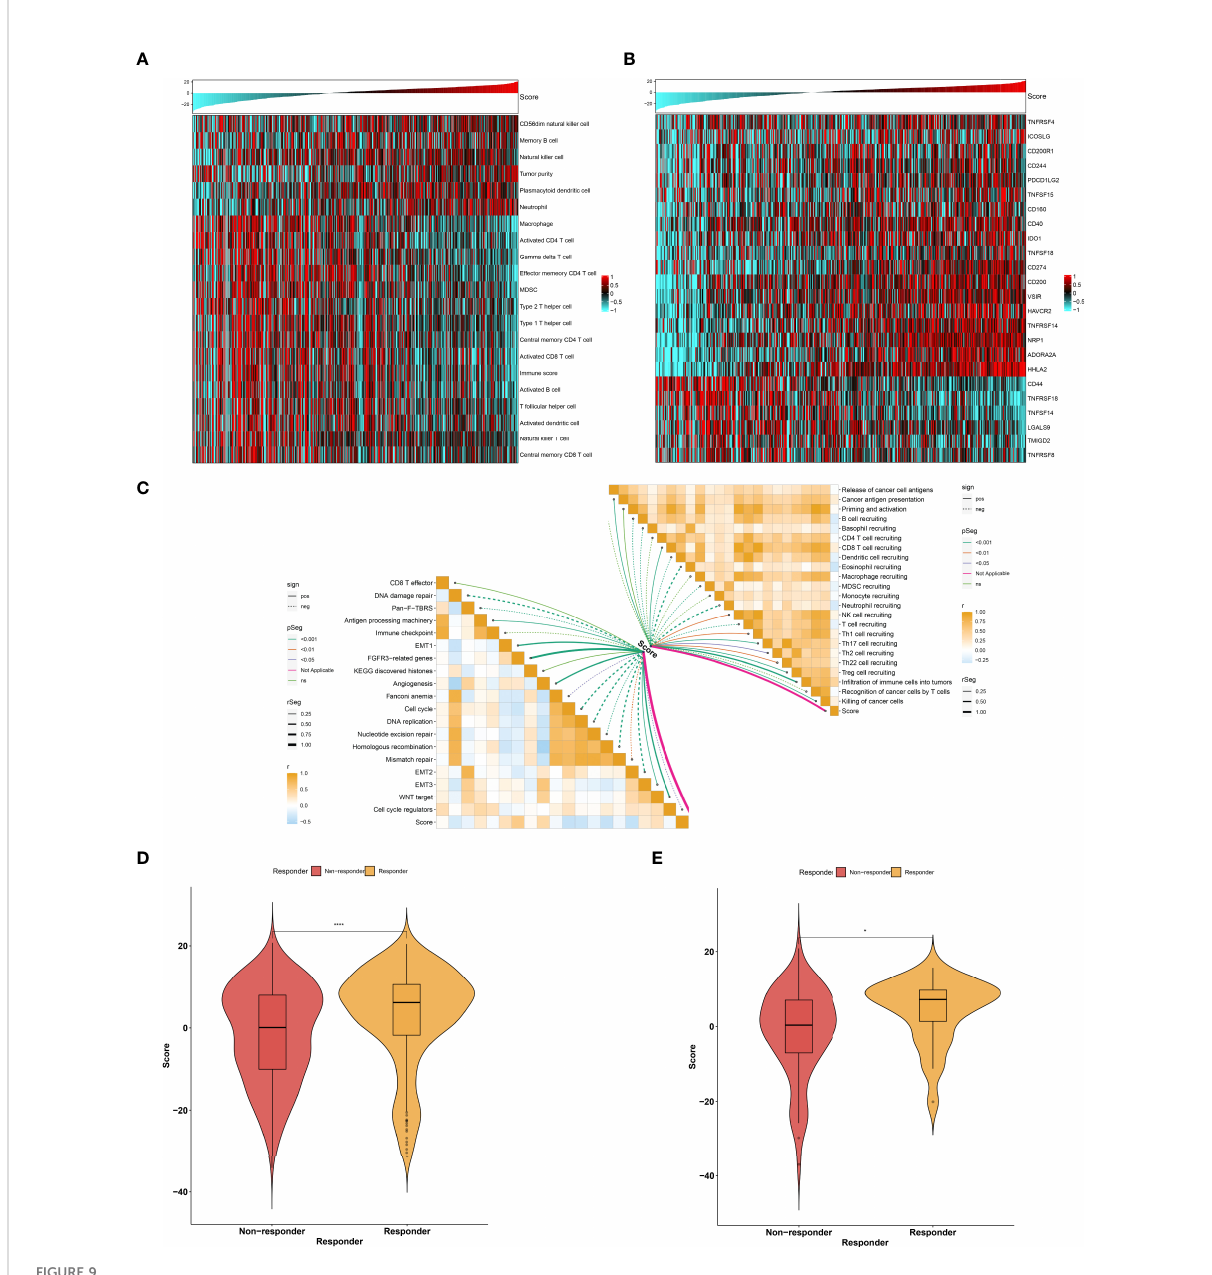
FIGURE 9 Association between agingScore and antitumor immune responses. (A) Landscape of immune cell in fi ltrations in the high as well as low agingScore groups in the TCGA-KIRC dataset. (B) Distribution of the expression of immune checkpoint molecules in the high and low agingScore groups in the TCGA-KIRC cohort. (C) Association of agingScore with activities of cancer immunity cycle and known biological processes in the TCGA-KIRC dataset. Solid lines represent positive correlations, while dashed lines represent negative correlations. (D) Prediction of response to immunotherapy in the TCGA-KIRC dataset. (E) Validation of the response to immunotherapy in the high and low agingScore groups in the E-MTAB-1980 cohort. * P < 0.05; **** P <